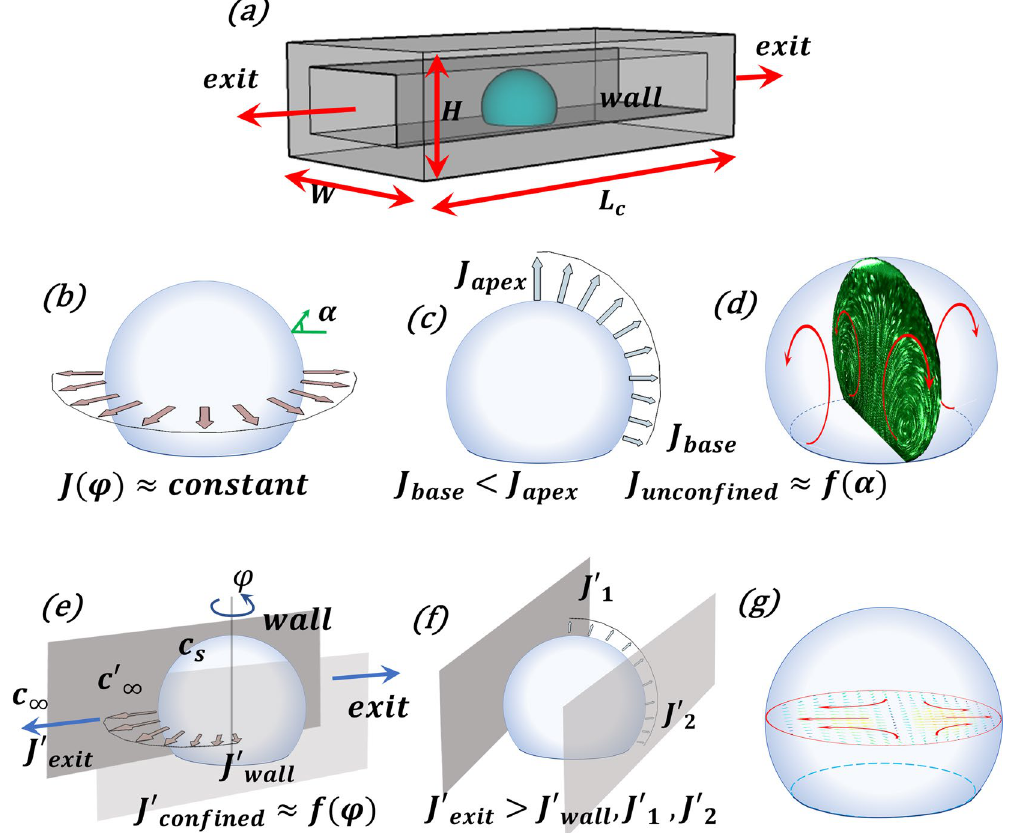
Figure 1. Overview of the experimental conditions. ( a ) Schematic showing the confined droplet. Variation in evaporation flux and flow patterns for unconfined ( b – d ) and confined ( e – g ) droplets. For unconfined droplets, evaporation is uniform in azimuthal direction ( b ) rather than polar direction ( c ) resulting in recirculating toroidal flow ( d ). For confined droplets, evaporation is comparatively more non-uniform in azimuthal direction ( e ) than polar ( f ). This leads to a directional flow from wall to open side ( g ). Arrows around the droplet periphery denote the evaporation flux. Channel top plate is not shown for simplicity. Here, ′ ∞ c : increased vapor concentration in the channel due to entrapment, c ∞ and c s : ambient and saturated vapor concentrations